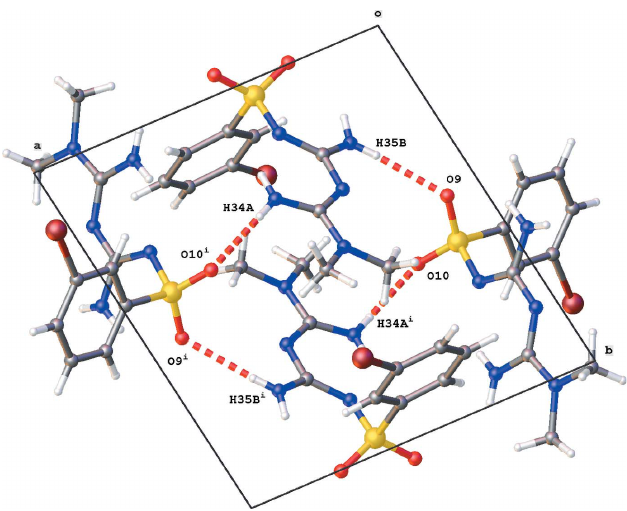
Figure 5 Partial crystal packing of the title compound, showing R 4 4 (20) ring